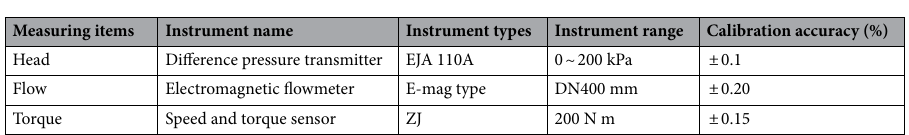
Table 2. Main instruments of the experimental measurement system.